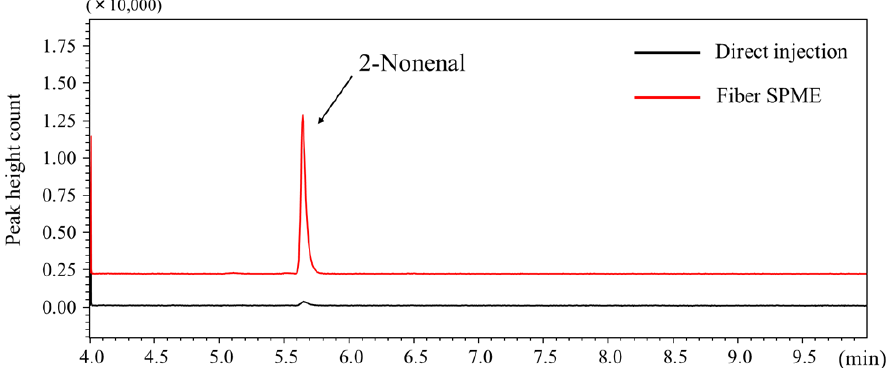
Figure 3. Typical total ion chromatogram of 2-nonenal obtained by (a) direct injection (200 ng/mL solution, 1 µL) and HS – SPME (200 ng/mL solution, 100 µL in 40-mL vial).